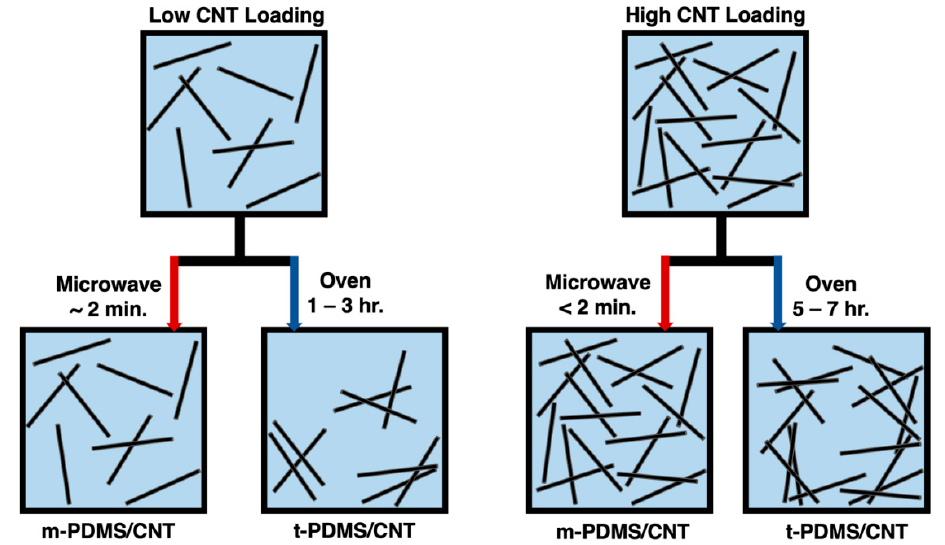
Figure 4. Schematic of increased dispersion for m-PDMS/CNT due to reducing CNT settlement effect expected in t-PDMS/CNT for low and high CNT loadings.